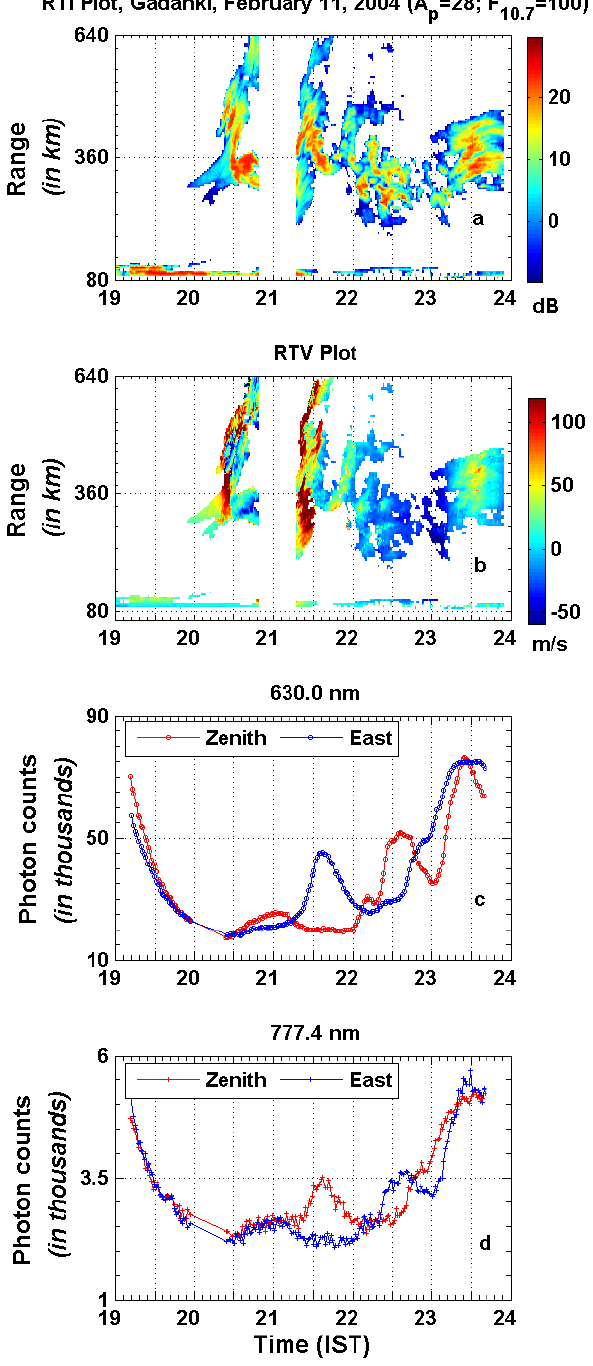
Fig. 1. (a) Range-Time-Intensity (RTI) map of equatorial spread F structures observed over Gadanki on 11 February 2004 revealing wave-like bottomside structure with large altitude extents, (b) the corresponding Range-Time-Velocity (RTV) map, (c) temporal vari- ations of OI 630.0nm airglow intensity over zenith (red) and 45 ◦ eastern (blue) directions, (d) temporal variations of OI 777.4nm airglow intensity over zenith (red) and 45 ◦ eastern (blue)